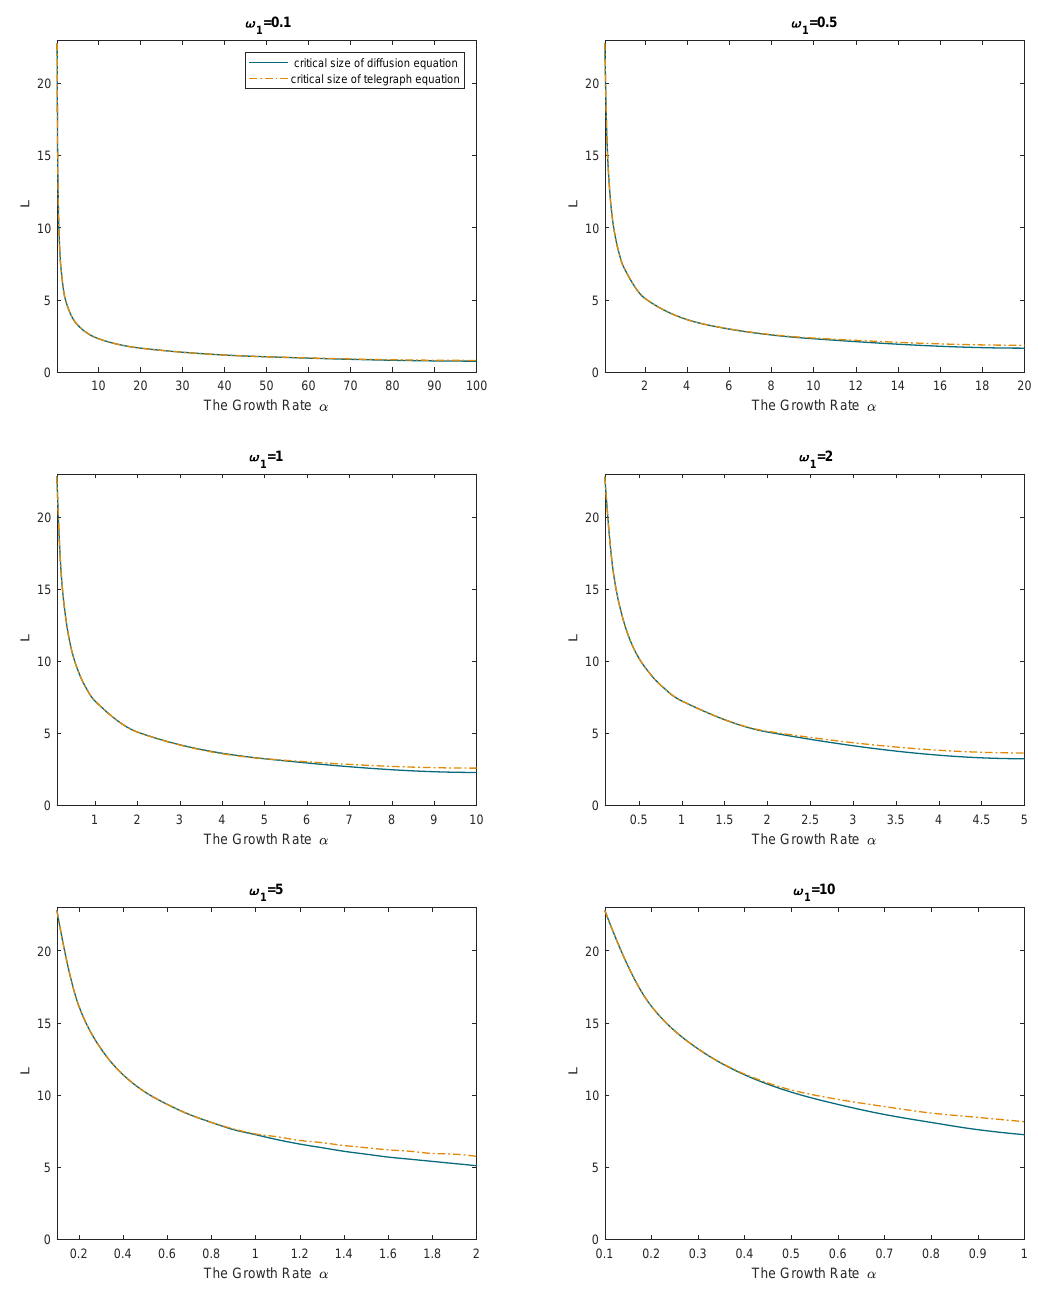
Figure 3. Dependence of the critical domain size on parameter α in case the population growth is subject to the strong Allee effect (see Equation (31)). The dashed orange curve shows the results for the reaction–telegraph Equation (29), and the solid blue curve shows the results obtained for the corresponding reaction–diffusion equation, i.e., Equation (29) with ω 1 = 0. Other parameters are K = 1, D = 1, β =